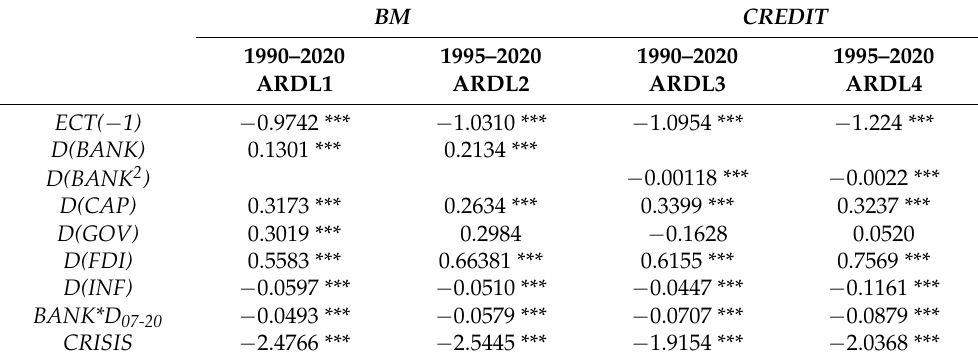
Table 4. Estimation results of ECM